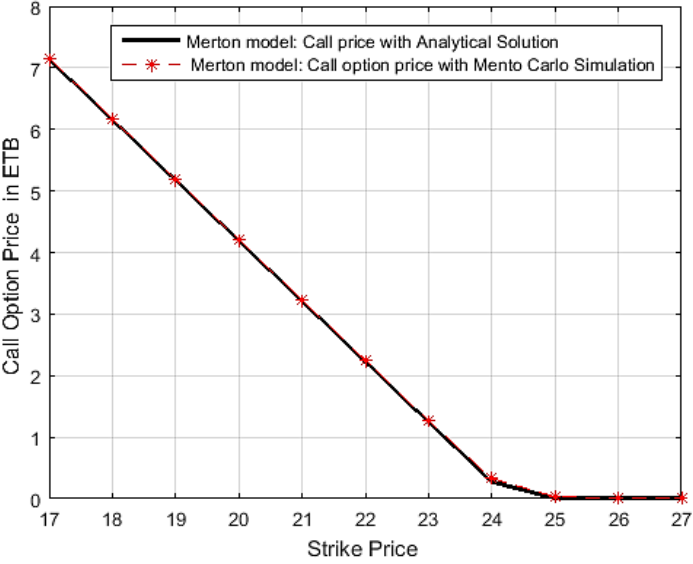
Figure 10. Call option WHGS3 price under Merton’s model.